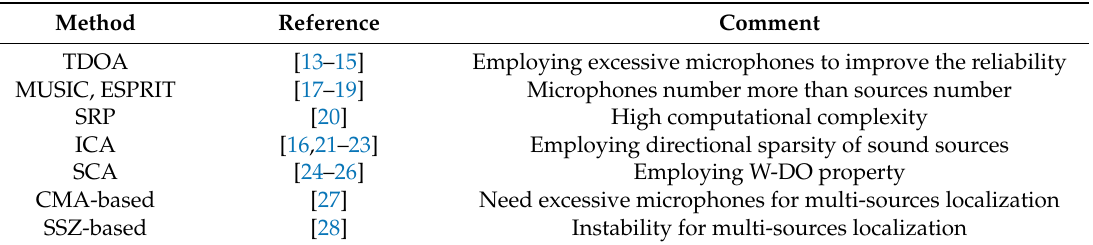
Table 1. Summary of the sound source localization